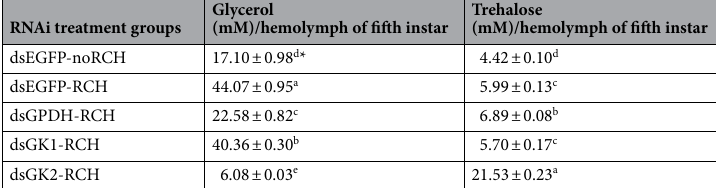
RNAi treatment groups